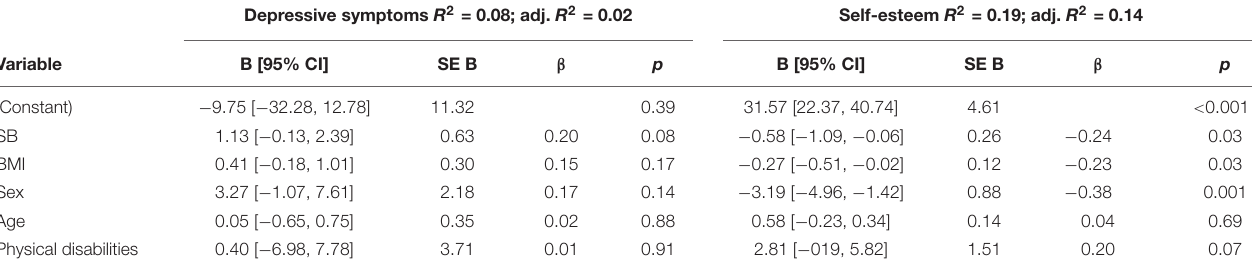
TABLE 5 | Regression analyses of SB on depressive symptoms and self-esteem.